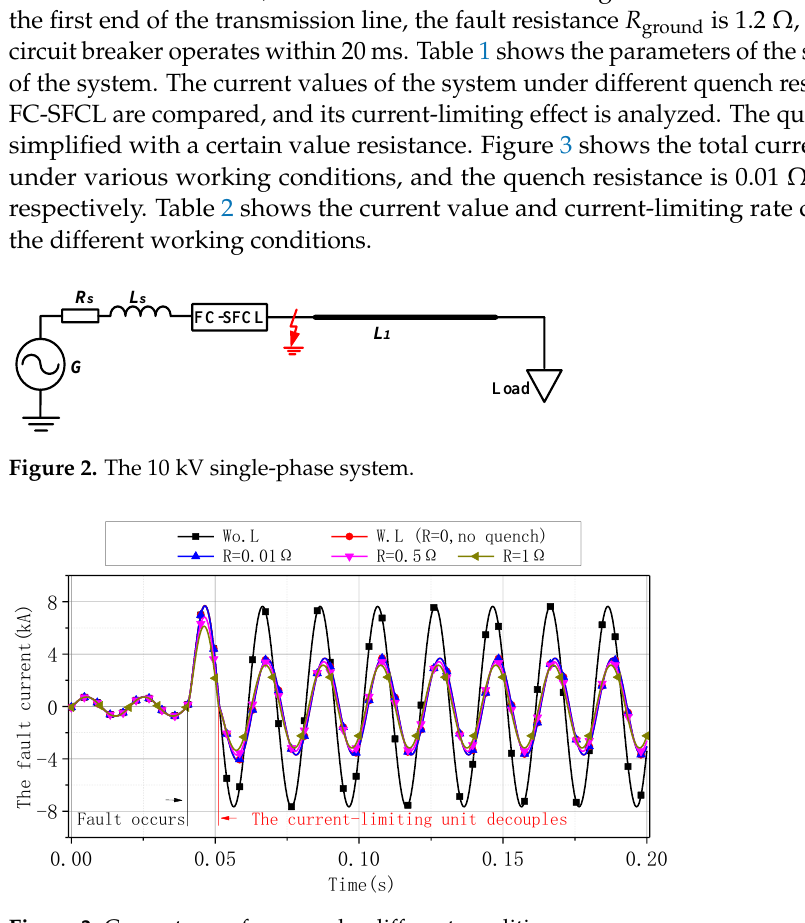
Figure 3. Current waveforms under different conditions.